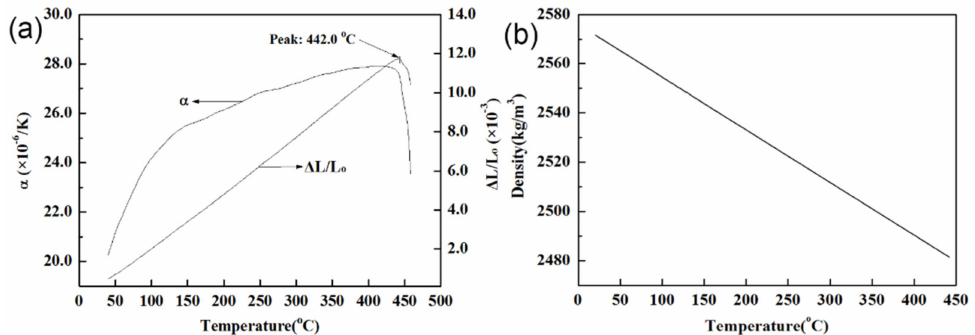
Figure 5. ( a ) Linear expansion coefficient and relative elongation vs. temperature, ( b ) linear fitting curve of density vs.